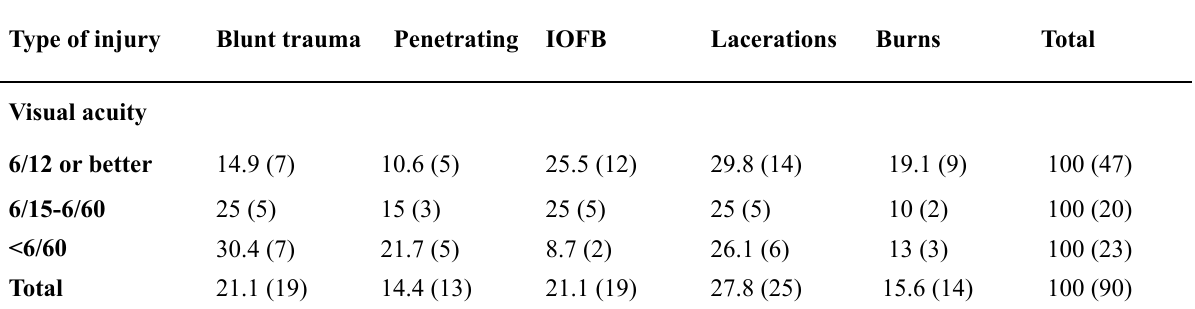
Table 3 . Types of injuries (in % and numbers ( n )) in relation to visual